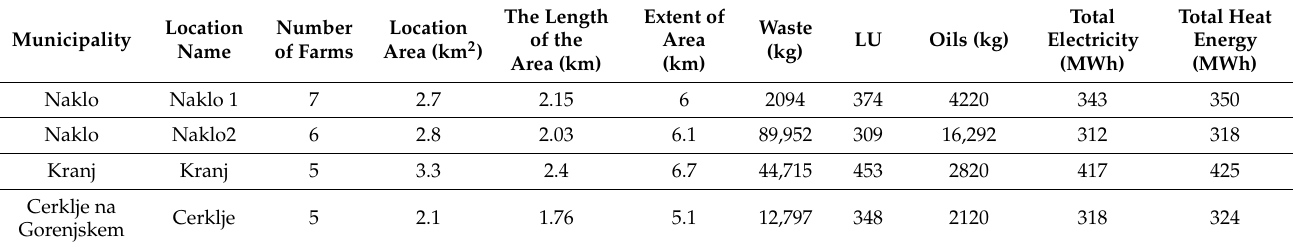
Table 3. Locations data.